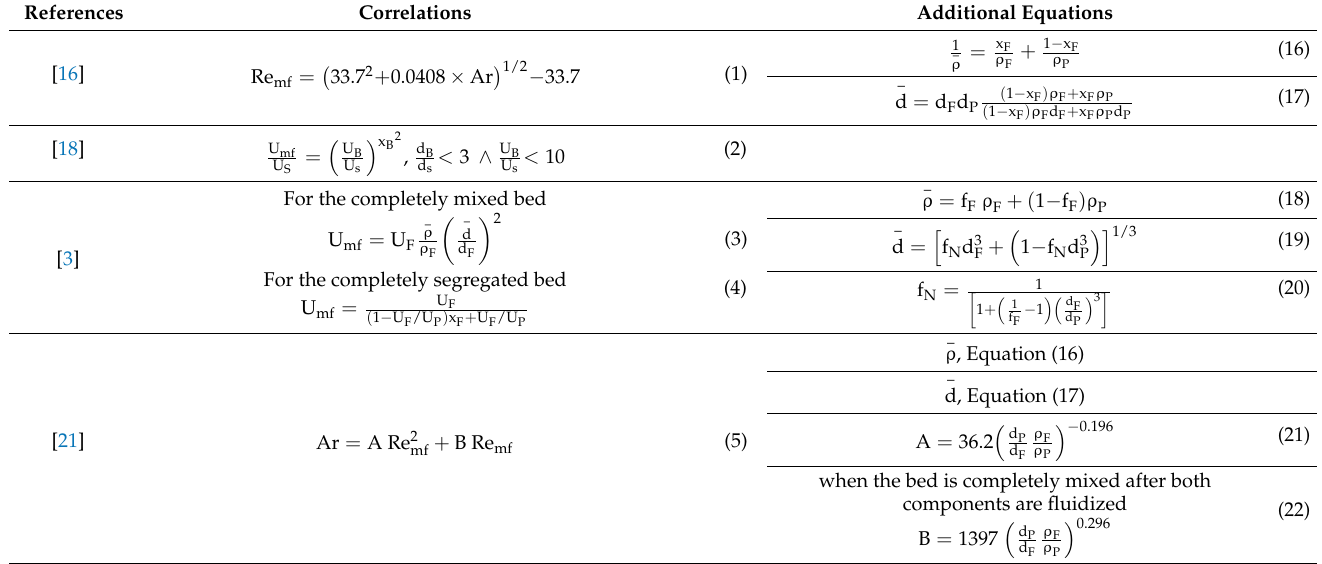
Table 1. Modeling minimum fluidization velocities of binary